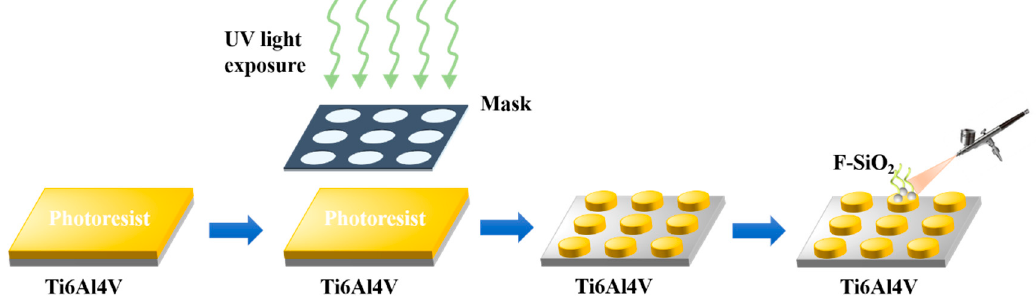
Figure 1. Schematic diagram of the procedure for the preparation of superhydrophobic array-microstructure surface.